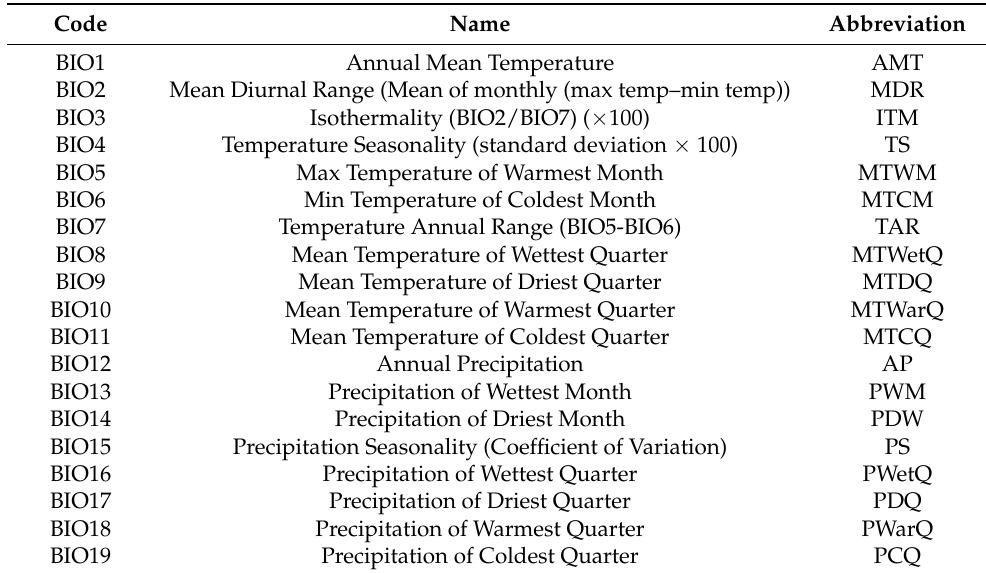
Table 4. The information on the bioclimatic